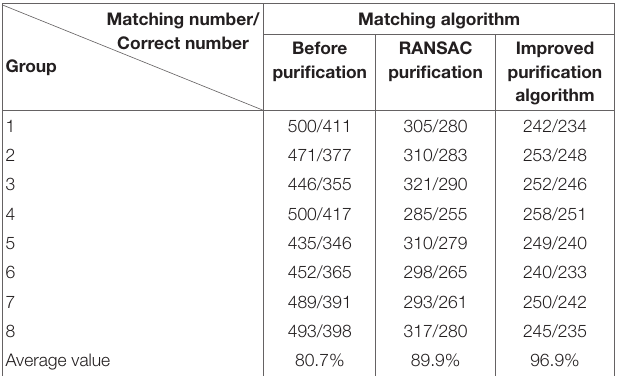
TABLE 1 | Comparison of purification algorithms for feature point matching.